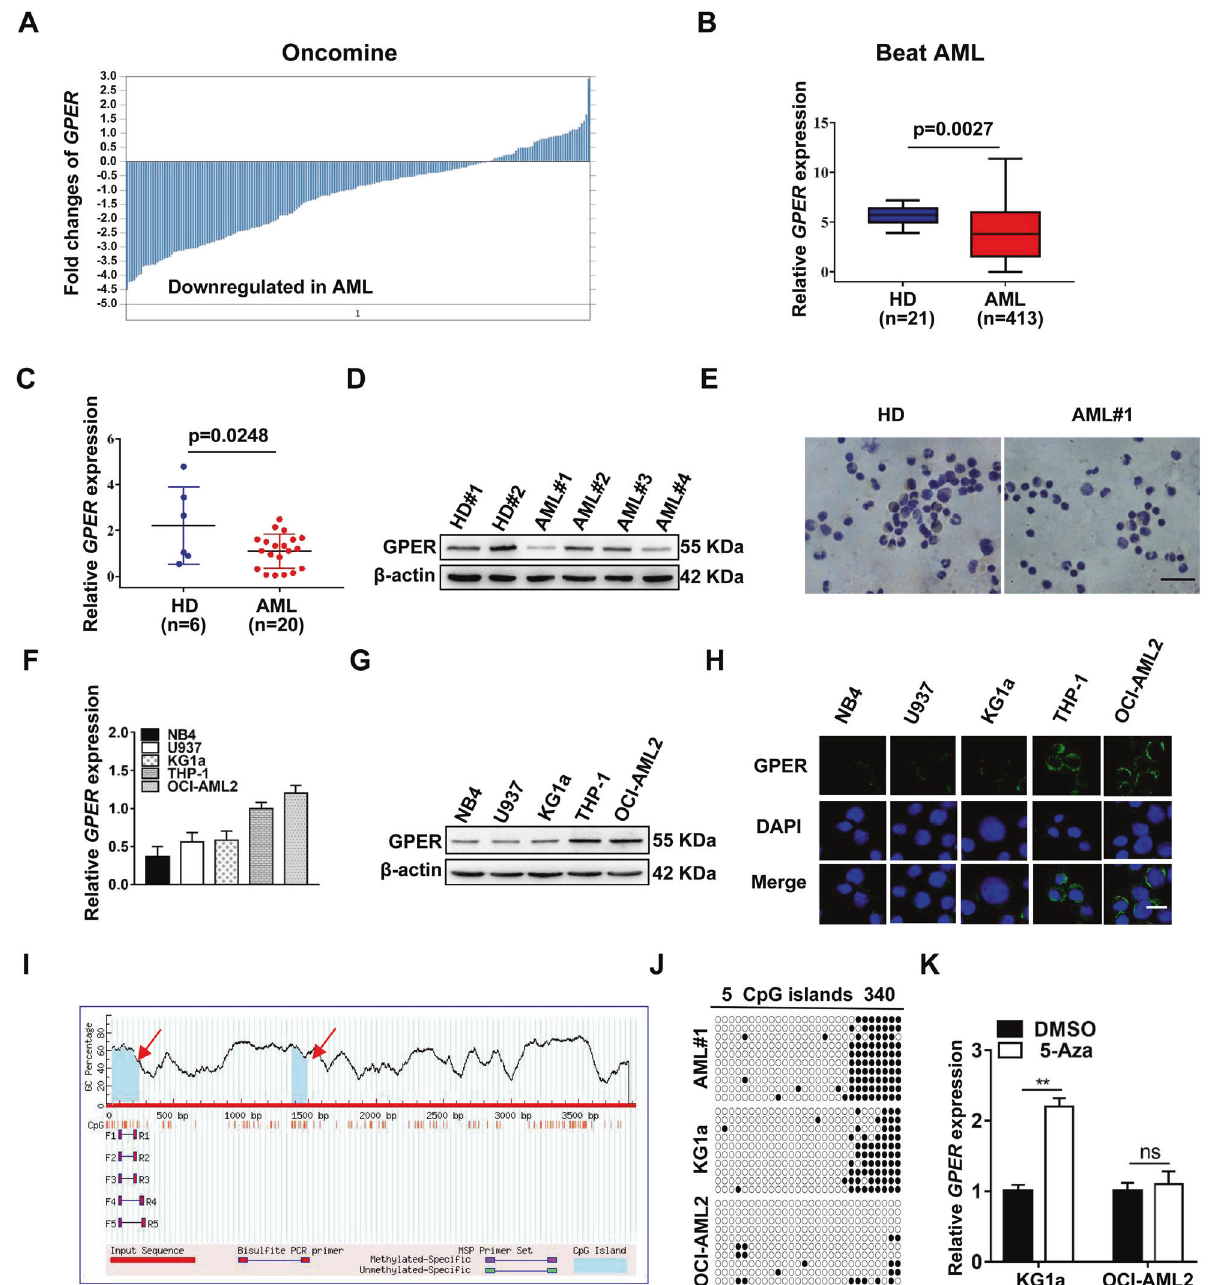
Fig. 1 GPER expression is decreased in leukemic cells. A , B GPER levels in AML patients and HD were identi fi ed from Oncomine and Beat AML databases. C – E qRT-PCR, western blot and IHC staining analyses of GPER levels in primary AML blasts and counterparts from HD